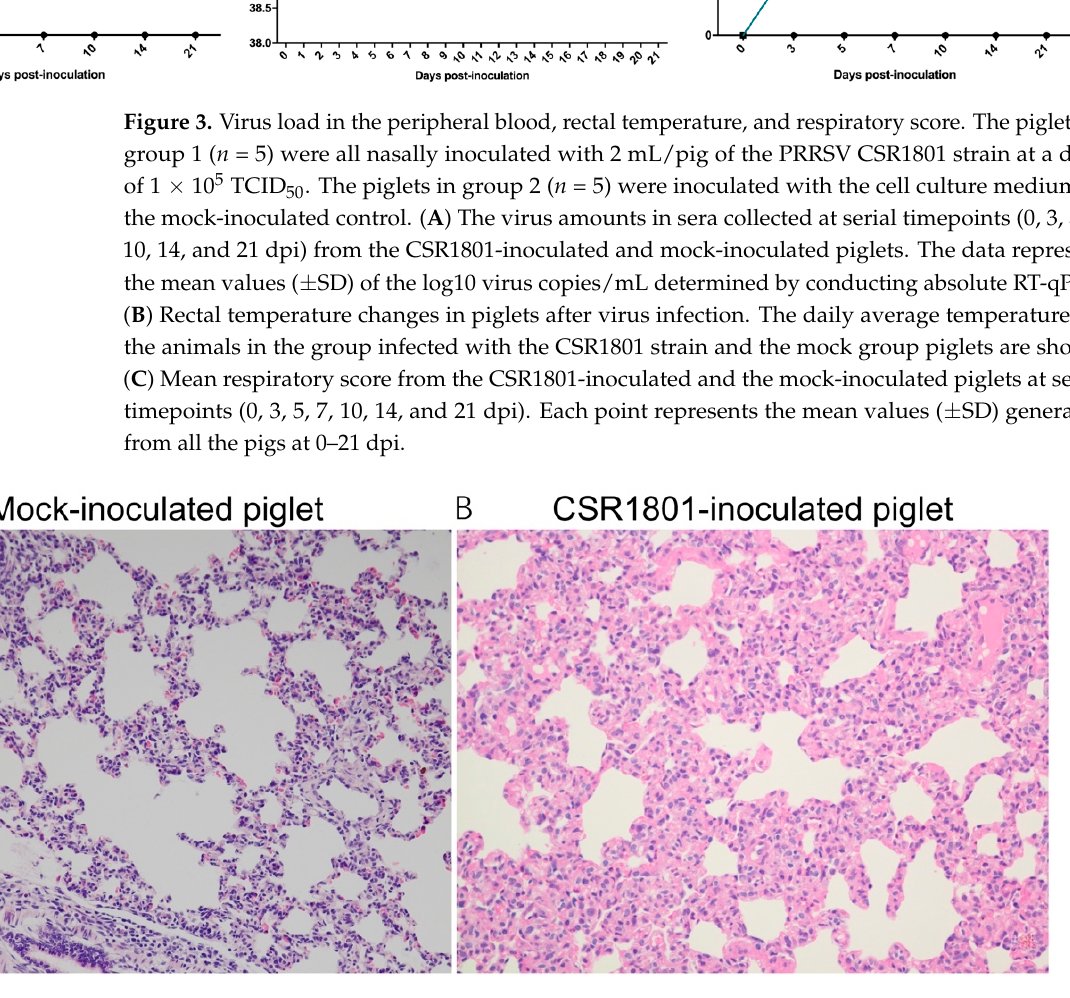
Figure 4. Histopathological results. The piglets in group 1 ( n = 5) were all nasally inoculated with 2 mL/pig of the PRRSV CSR1801 strain at a dose of 1 × 10 5 TCID 50 . The piglets in group 2 ( n = 5) were inoculated with the cell culture medium as the mock-inoculated control. Histopathological examination of lung tissue from the PRRSV CSR1801—and of the mock-inoculated piglets at 21 dpi was performed using routine hematoxylin and eosin staining method, respectively. The results showed a mild lymphocytic interstitial pneumonia in lungs from the PRRSV CSR1801-inoculated piglets. Magnification, 200 ×